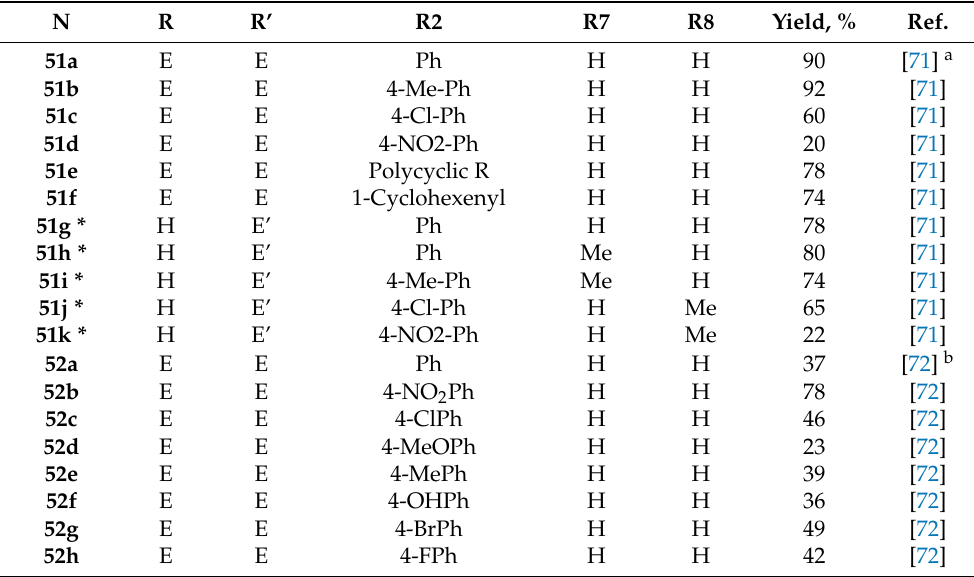
Table 12. Substituents and yields of microwave three-component synthesis of cyclazines (Scheme 26). N R R’ R2 N R 51a